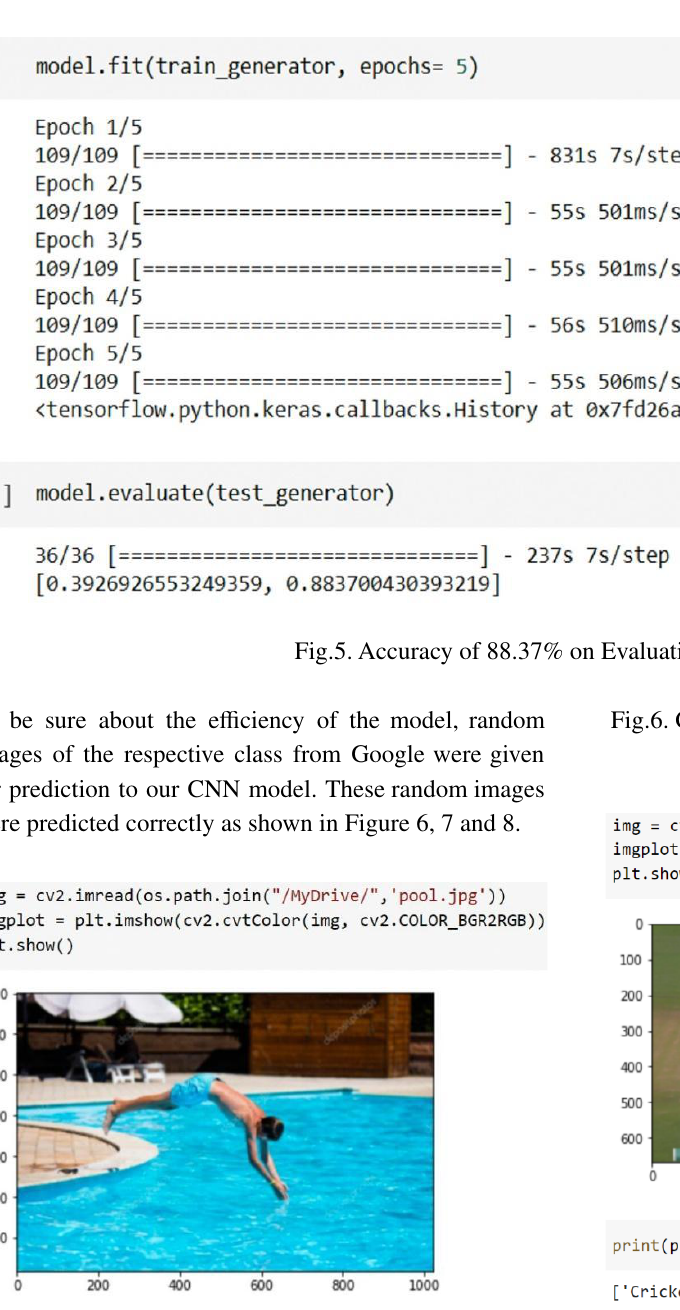
Fig.7. Class Prediction on a random